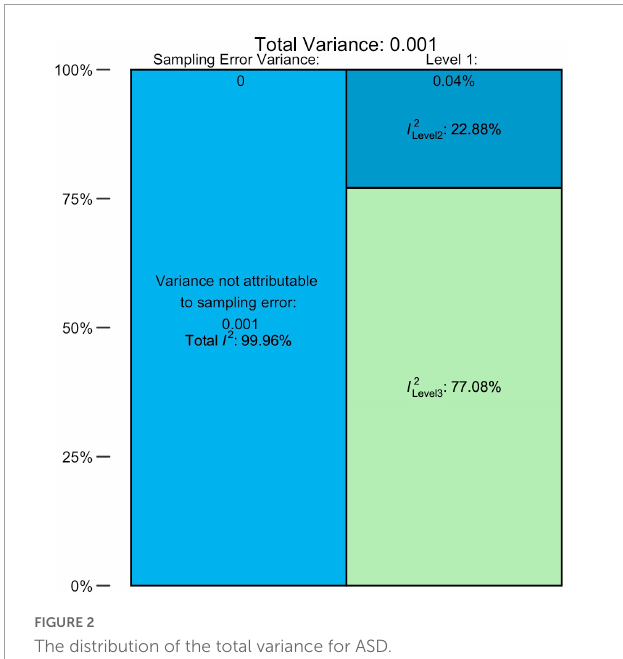
Table 8 . Overall, the sampling error on Level 1 was small and ranged from 1.30 to 2.57%. The values of I 2 on Level 2 were much higher, totaling from 14.19 to 59.73%, with the exclusion of the AS group, for which the within-study heterogeneity remained low (2.34%). In general, the largest share fell to Level 3 (between-study) of heterogeneity, which explained 84.51 and 95.09% of variance for AD and AS groups, respectively. Interestingly, AA/PDD-NOS was behind this trend: for this group, between-study heterogeneity (44.80%) was lower than within-study